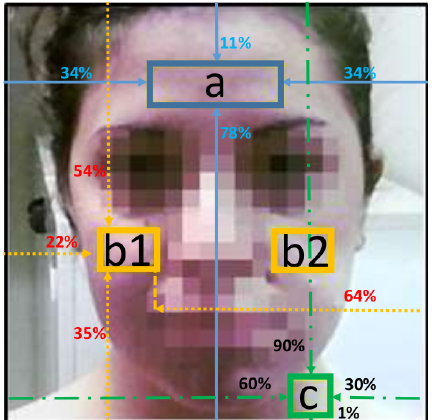
Figure 3. Selected regions of interest: ( a ) Forehead (F); ( b1 , b2 ) Cheeks (C); ( c ) Neck (N). Some details are blurred to preserve the subject’s privacy. The ROIs are selected considering the percentage of the detected face area shown in the